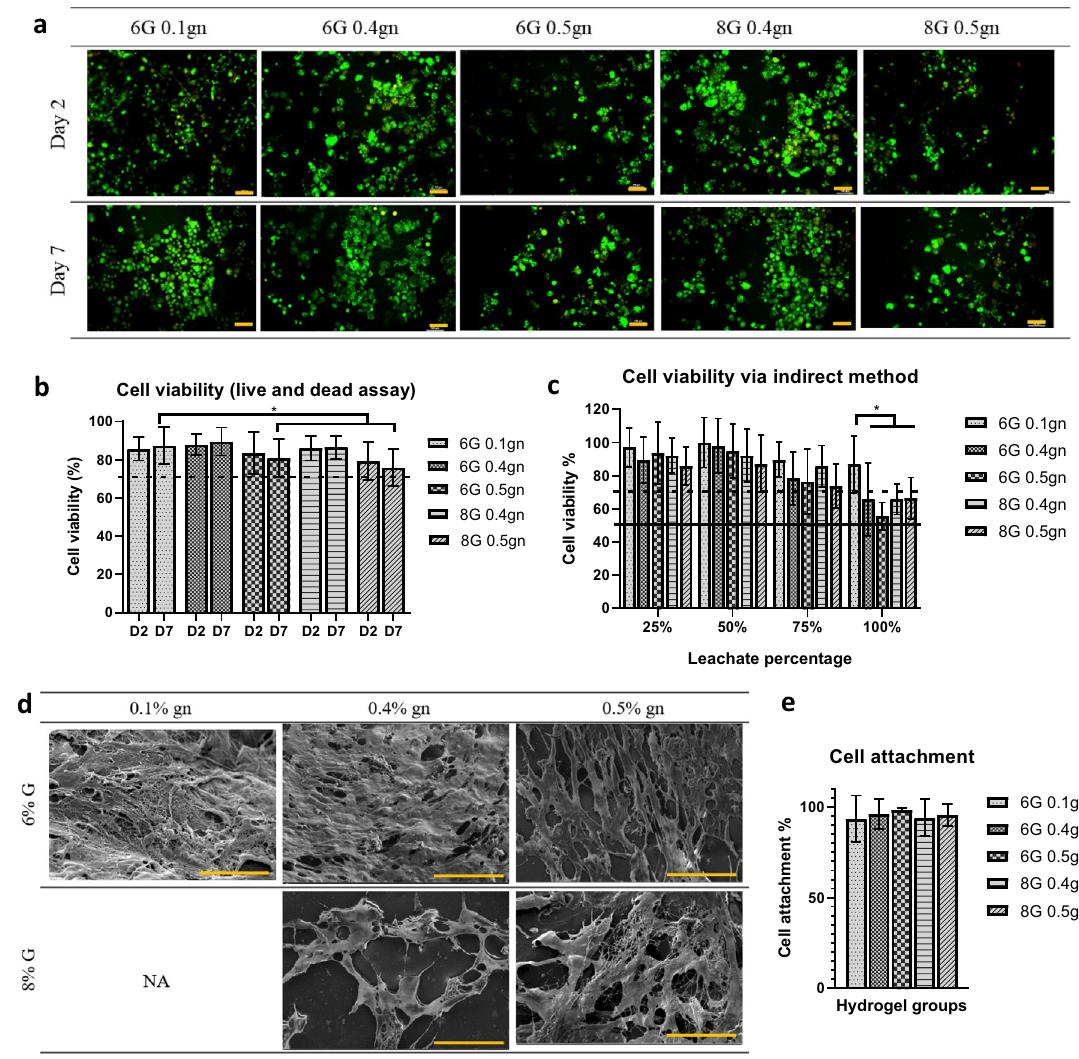
Figure 4. WJMSCs interaction with genipin-crosslinked gelatin hydrogels (N = 3, n = 9, * p < 0.05). ( a ) WJMSCs image of live and dead assay which were seeded on top genipin-crosslinked gelatin hydrogels at Day 2 and Day 7. ( b ) Cell viability of WJMSCs which were seeded on top genipin-crosslinked gelatin hydrogels at Day 2 and Day 7. ( c ) Indirect effect of genipin-crosslinked gelatin hydrogels towards the viability of WJMSCs as determined by MTT assay. ( d ) SEM morphology of the hydrogel scaffolds seeded with WJMSCs. ( e ) Cell attachment of the WJMSCs on the genipin-crosslinked gelatin hydrogels at Day 2. Each yellow scale bar represents 100